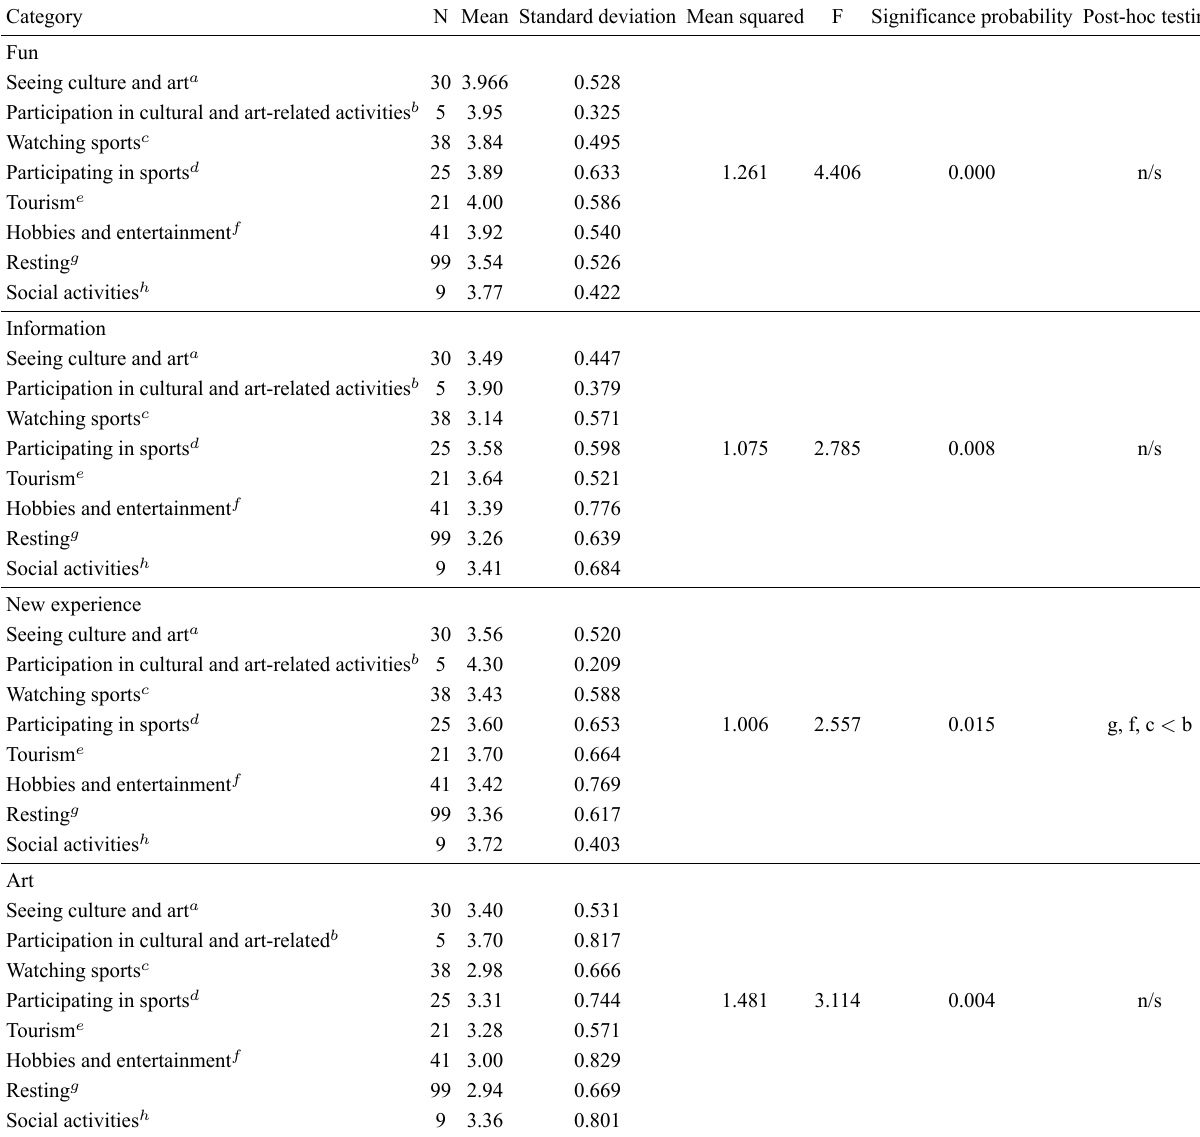
Table 6. Differences in leisure activities for high-risk group (n =